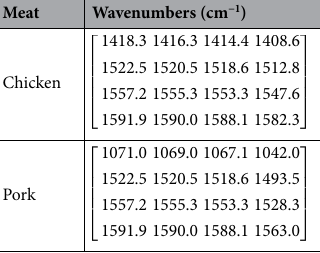
Table 3. Dominant wavenumbers for chicken and pork meats.